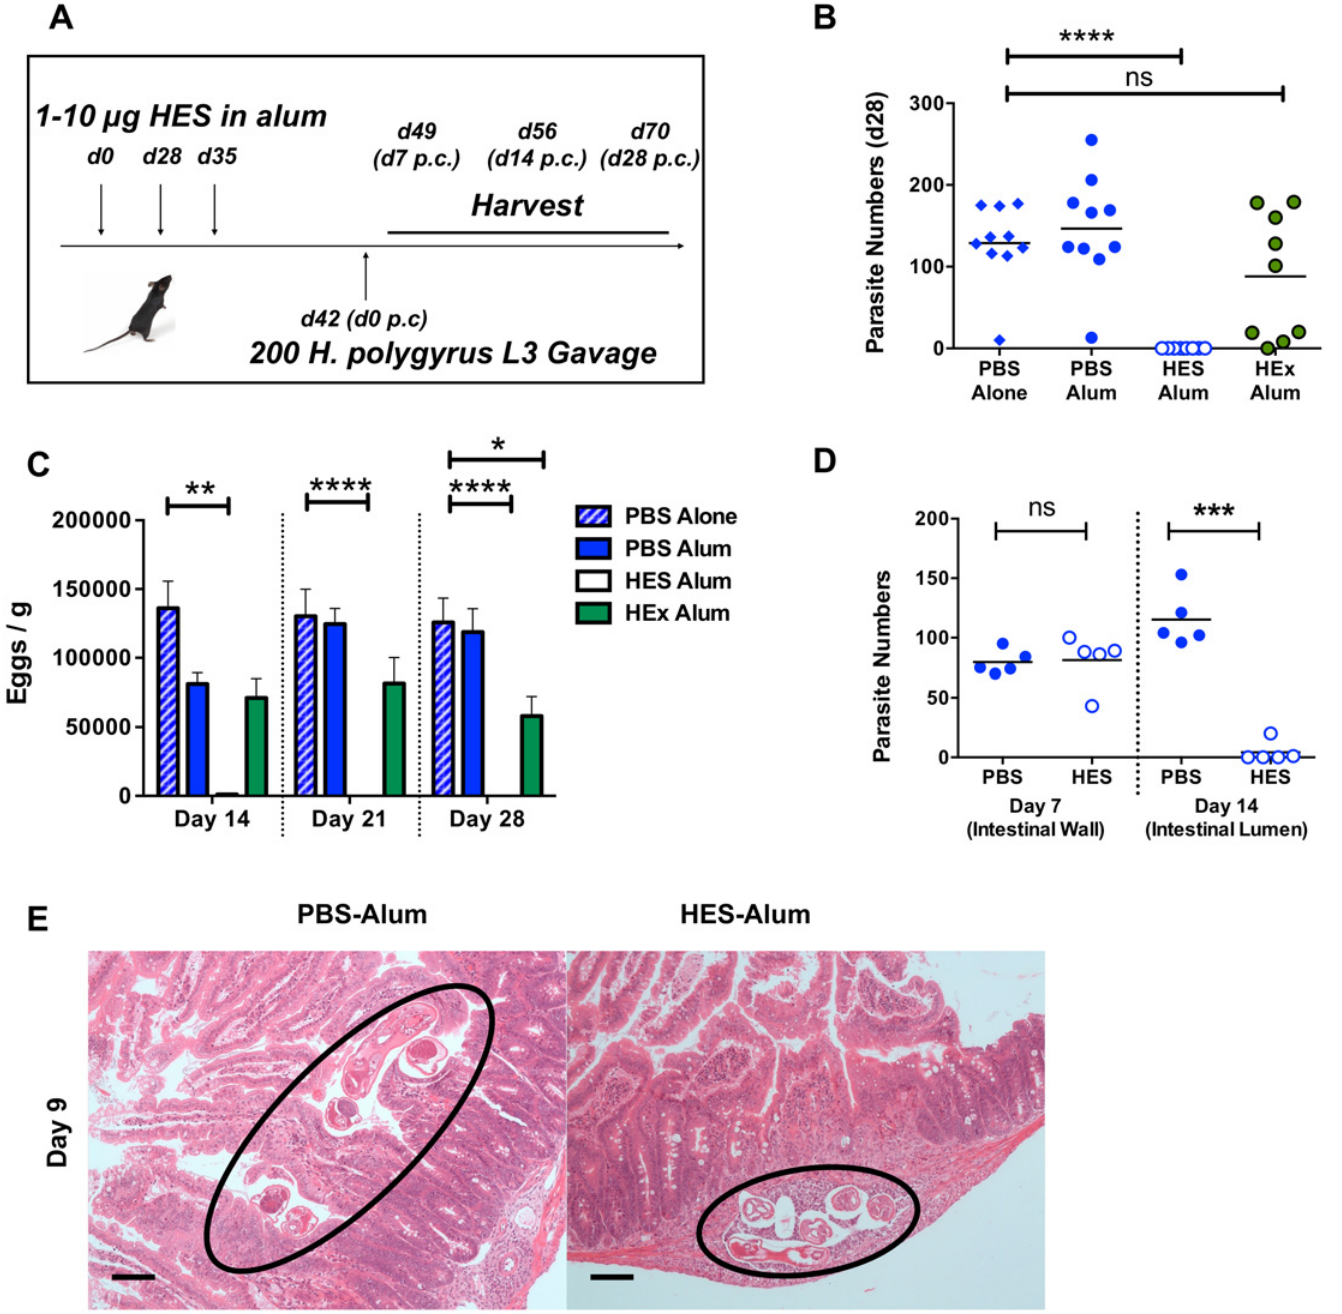
Fig 1. HES vaccination elicits sterile immunity to challenge and blocks parasite maturation. A . Schematic protocol for immunization. B . Parasite recoveries d 28 post-challenge following vaccination of C57BL/6 females with HES or somatic extract (HEx). Data shown are combined from two experiments each of 4 – 5 mice per group. Significance determined by ANOVA. C . Faecal egg counts (d 14, 21, 28 post-challenge) from (B). Significance determined by ANOVA. D . Parasite recoveries at d 7 (small intestinal wall) and 14 post-challenge (gut lumen). Representative of two independent experiments. Significance determined by t -test. E . H&E sections of duodenum in control and vaccinated animals at d9 post challenge; parasites in control animals are observed in gut lumen, but remain trapped in submucosa of vaccinated mice. Black circles indicate positions of parasite. Scale bar represents 100 μ m.